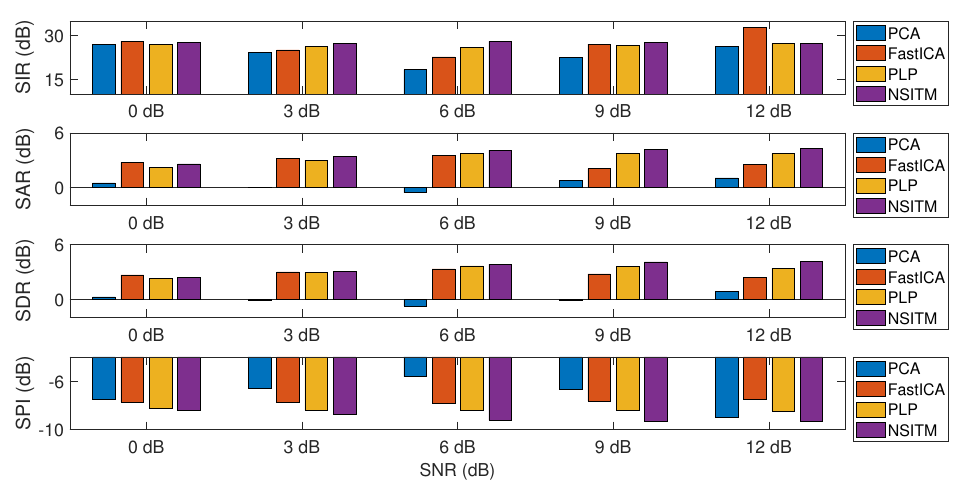
Figure 17. Comparing between the average values of the extraction metrics (SIR, SAR, SDR, and SPI), with the variations of the SNR, using NSTM, FastICA, PCA, and PLP algorithms. The values are taken from Tables 2–4. SIR, SAR, and SDR are computed using Equations (26)–(28). SPI is computed using Equation